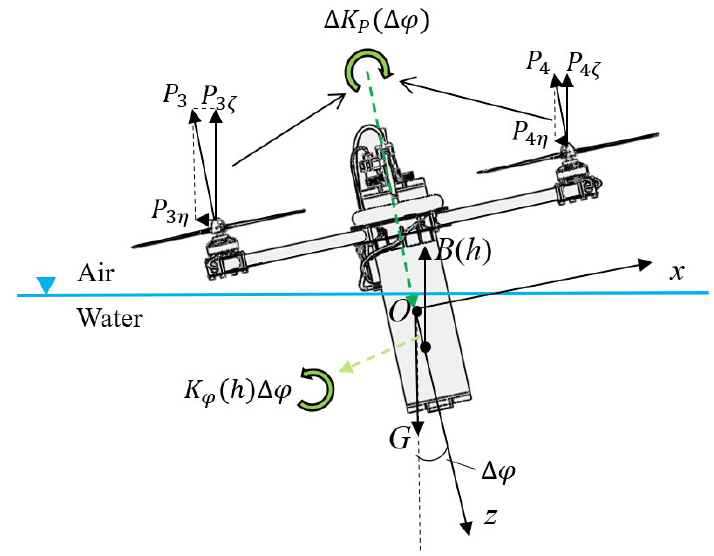
Figure 8. Static force analysis in the η E ζ plane. (cid:4666)∆(cid:2030)(cid:4667) is the torque, which the propeller needs to provide, varying with ∆(cid:2030) . It (cid:1837) (cid:3017)